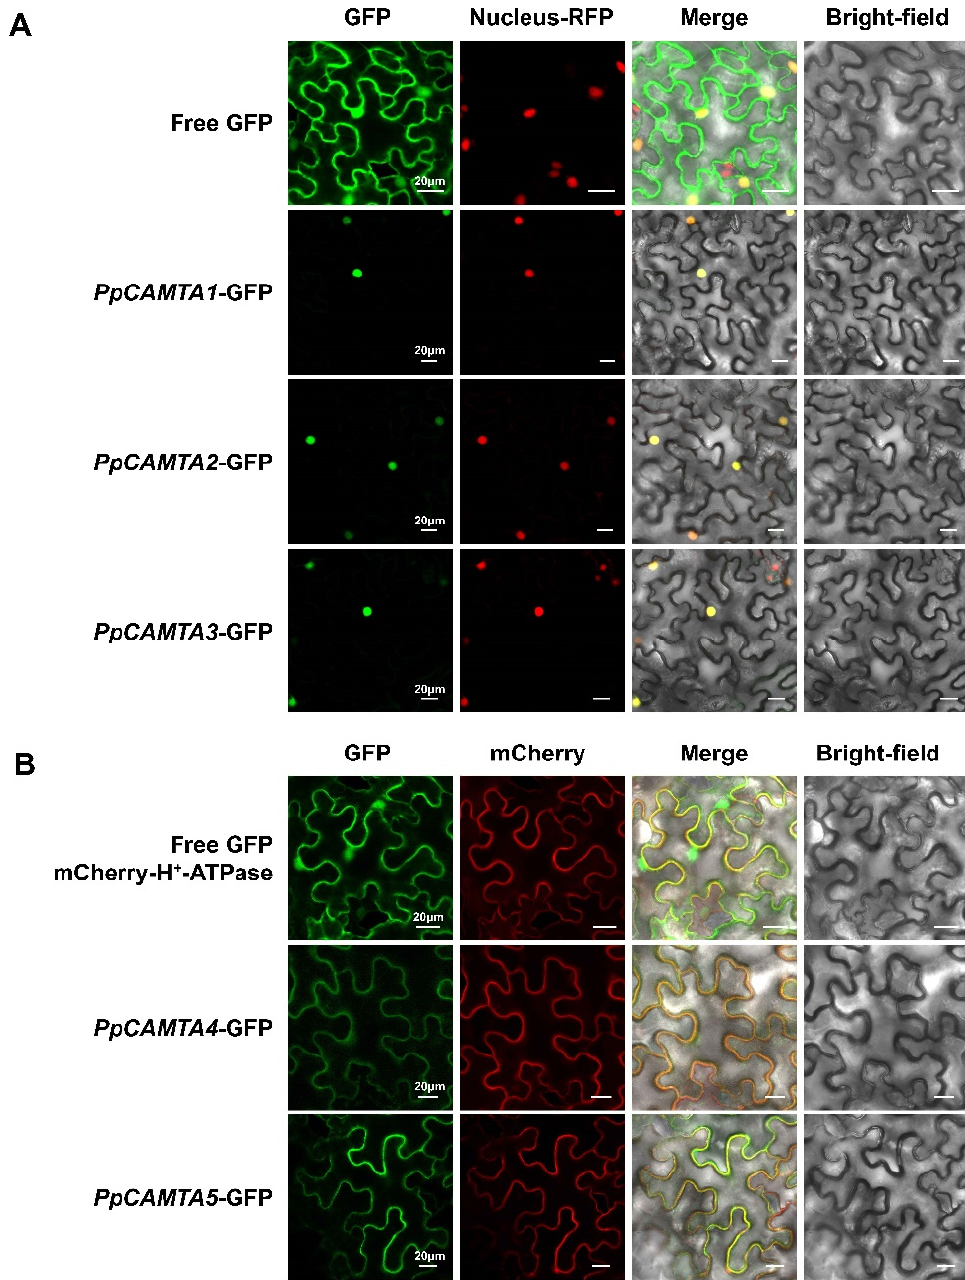
Figure 6. Subcellular localization of peach CAMTAs in Nicotiana benthamiana leaves. ( A ) Subcellular localization of PpCAMTA1, PpCAMTA2, PpCAMTA3. ( B ) Subcellular localization of PpCAMTA4, PpCAMTA5. GFP, GFP channel; Nucleus–RFP, transgenic tobacco with red fluorescence in the nucleus; mCherry-H + -ATPase, mCherry signal of H + -ATPase with red fluorescence as a marker in the plasma membrane; Merge, merged image of the GFP and nucleus–RFP or mCherry channels; Bright-field, light microscopy image; bars = 20 µm.